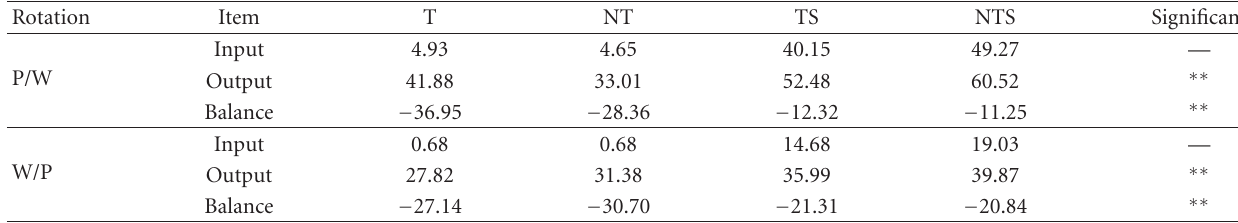
Table 6: Potassium balance under di ff erent treatments over 5 years (kgKha − 1